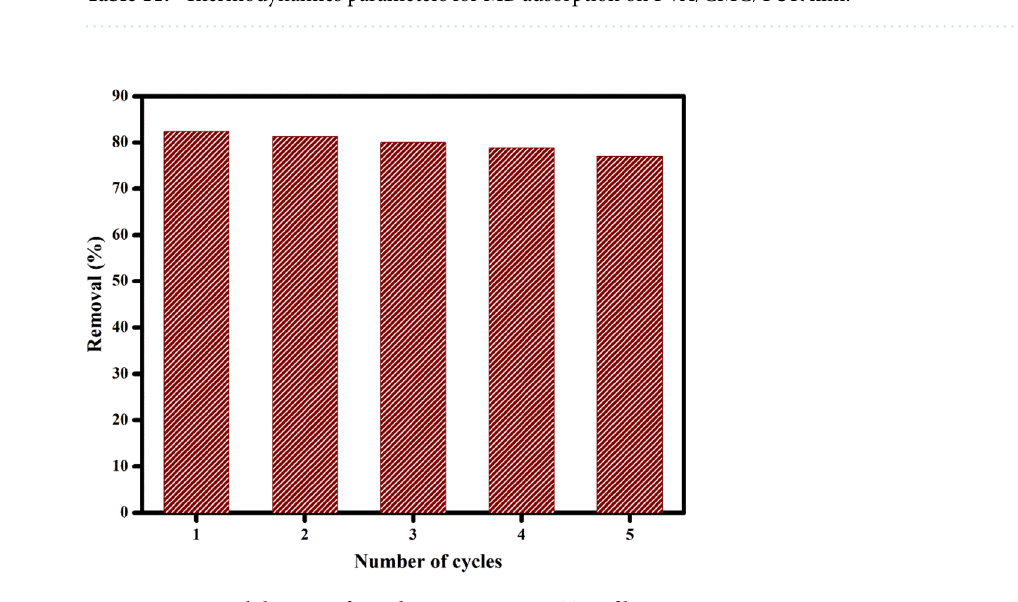
Figure 18. Reusability test of MB dye on PVA/CMC/TUR film.